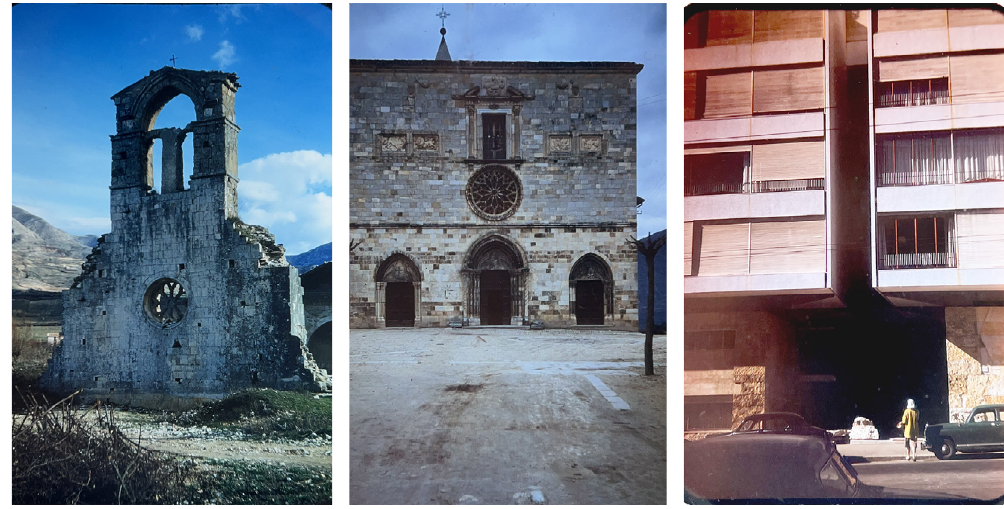
Fig. 8 Robert Venturi, Surface . Color slides from photographs taken by Robert